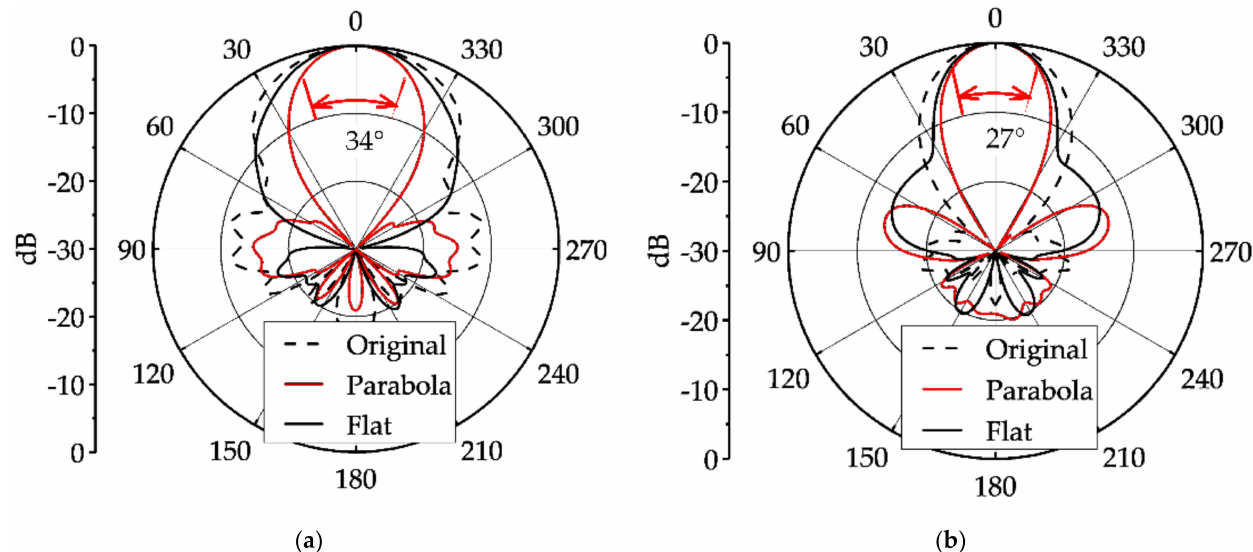
Figure 4. Simulated radiation patterns of three investigated antennas at 22.7 GHz. ( a ) E-plane; ( b ) H-plane.